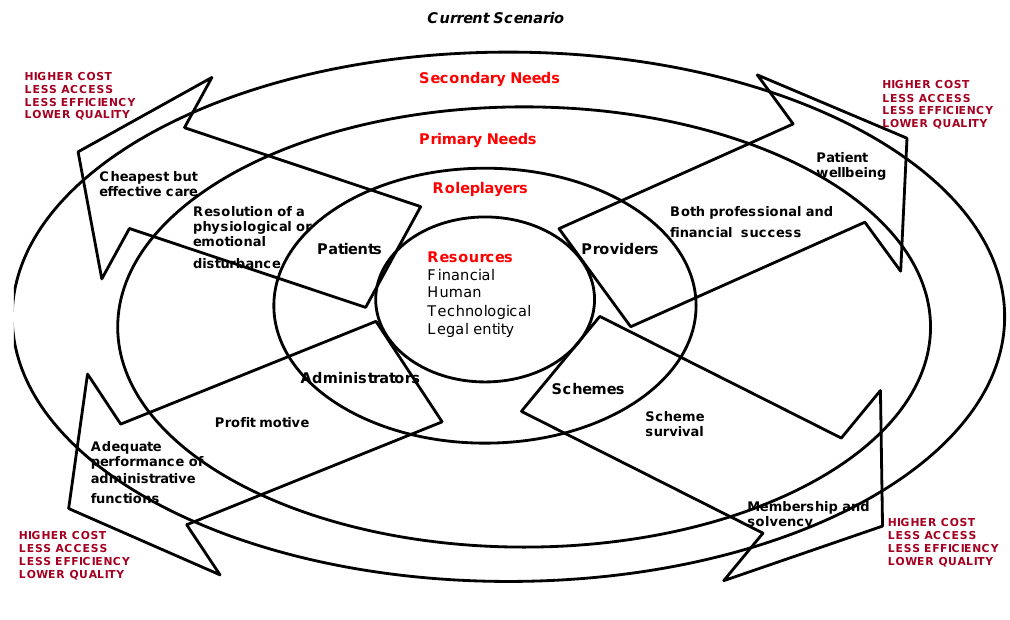
Figure 3: Resources, role-players and needs – the current